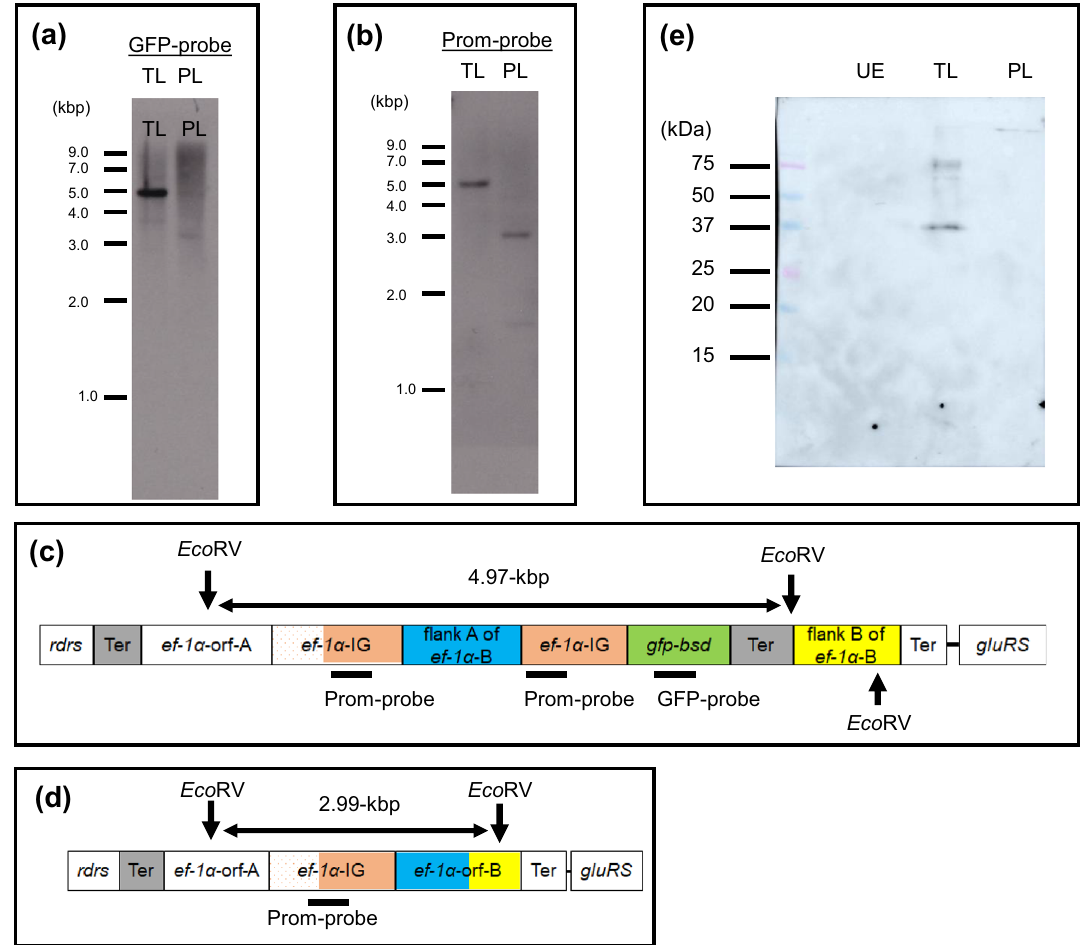
Figure 5. Graphical illustration of Southern blot and Western blot analyses. Genomic DNA extracted from the transgenic T . equi line (TL) and parental line (PL) was subjected to Southern blotting analyses after digestion with Eco RV. ( a ) A probe targeting the green fluorescent protein gene (GFP-probe) detected a single DNA fragment (4.9-kbp) in the genomic DNA (gDNA) obtained from the transgenic TL, but no such fragment was detectable in the PL. ( b ) A probe targeting the promoter region of the ef-1α gene (Prom-probe) detected a single 4.97-kbp fragment in the gDNA from the transgenic TL, whereas a 2.99-kbp fragment was detected in the PL. ( c ) Graphical illustration of ef-1α gene loci in the genome of the transgenic TL and Eco RV recognition sites. ( d ) Graphical illustration of ef-1α gene loci in the PL genome and Eco RV recognition sites. ( e ) In Western blot, an anti-GFP rabbit polyclonal antibody recognized a 40-kilodalton protein, corresponding to the size of eGFP/BSD, in lysate of TL but not in the lysates of PL and uninfected erythrocytes